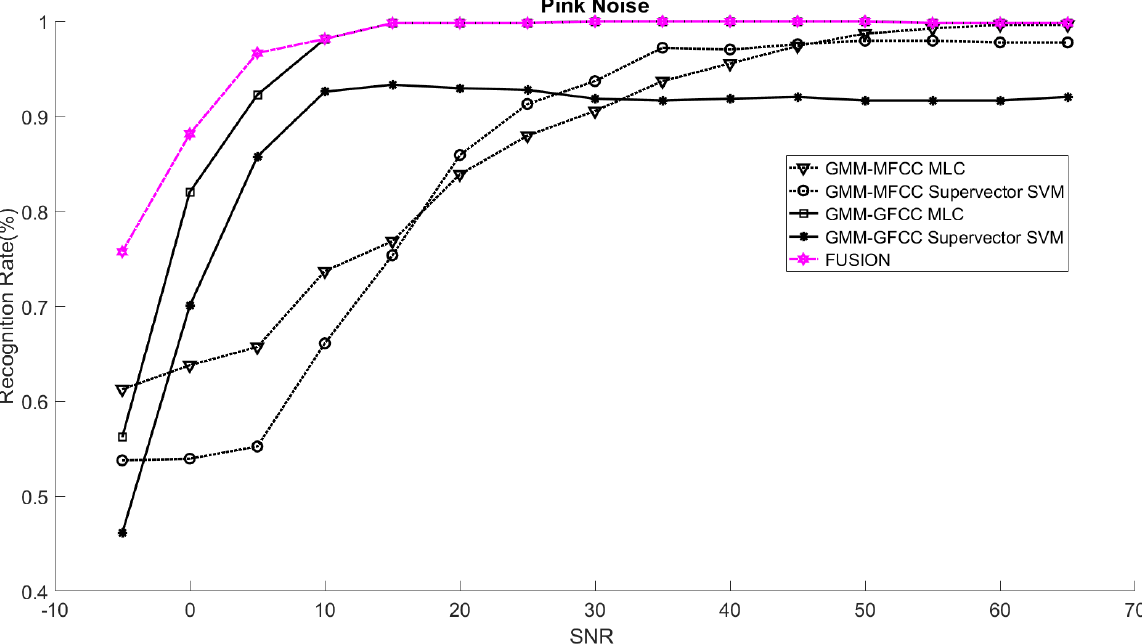
Figure 20. Rank-1 recognition rates of the fusion system and the base classifiers (two-stage) on utterances distorted with pink